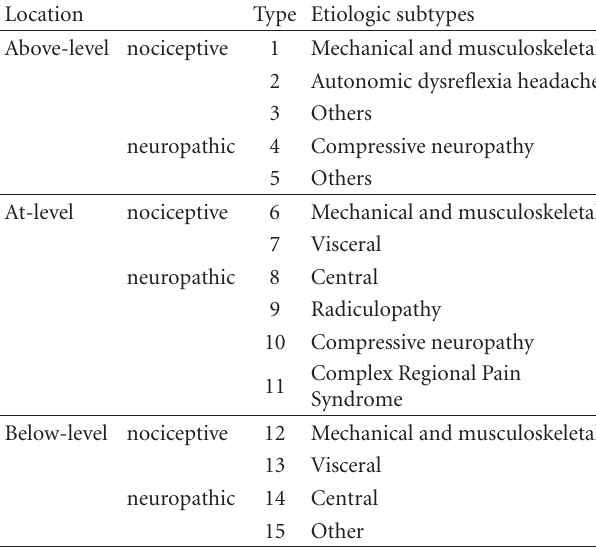
Table 2: SCI pain classification by Bryce and